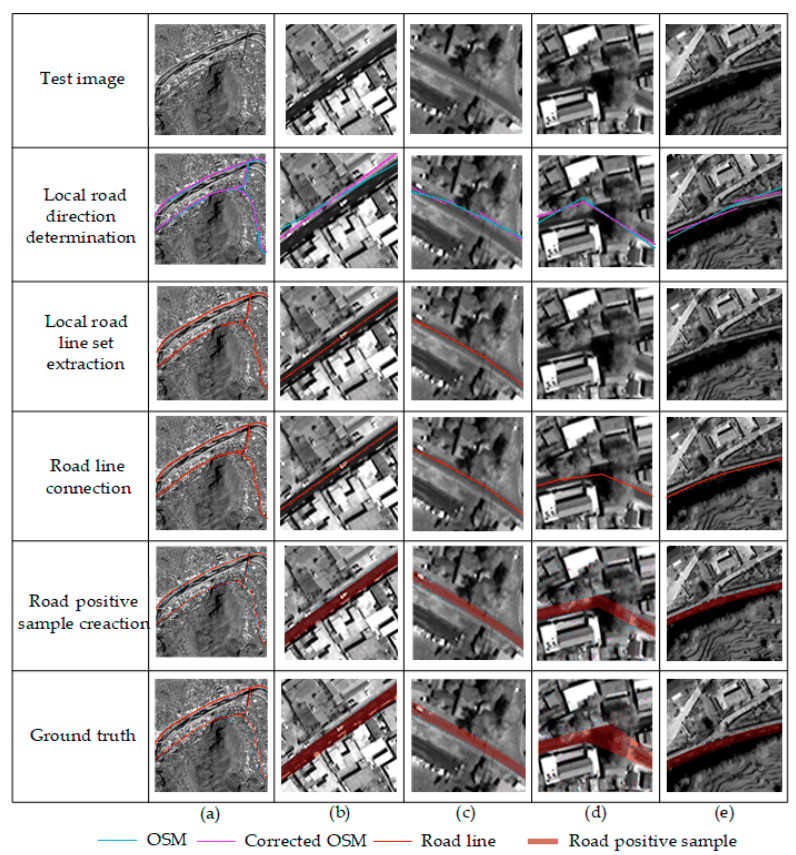
Figure 16. Partial display of the effect of the different steps; ( a–e ) the presence of vehicle noise, edge blur, a large curvature change, and tree shadow occlusion in the road.